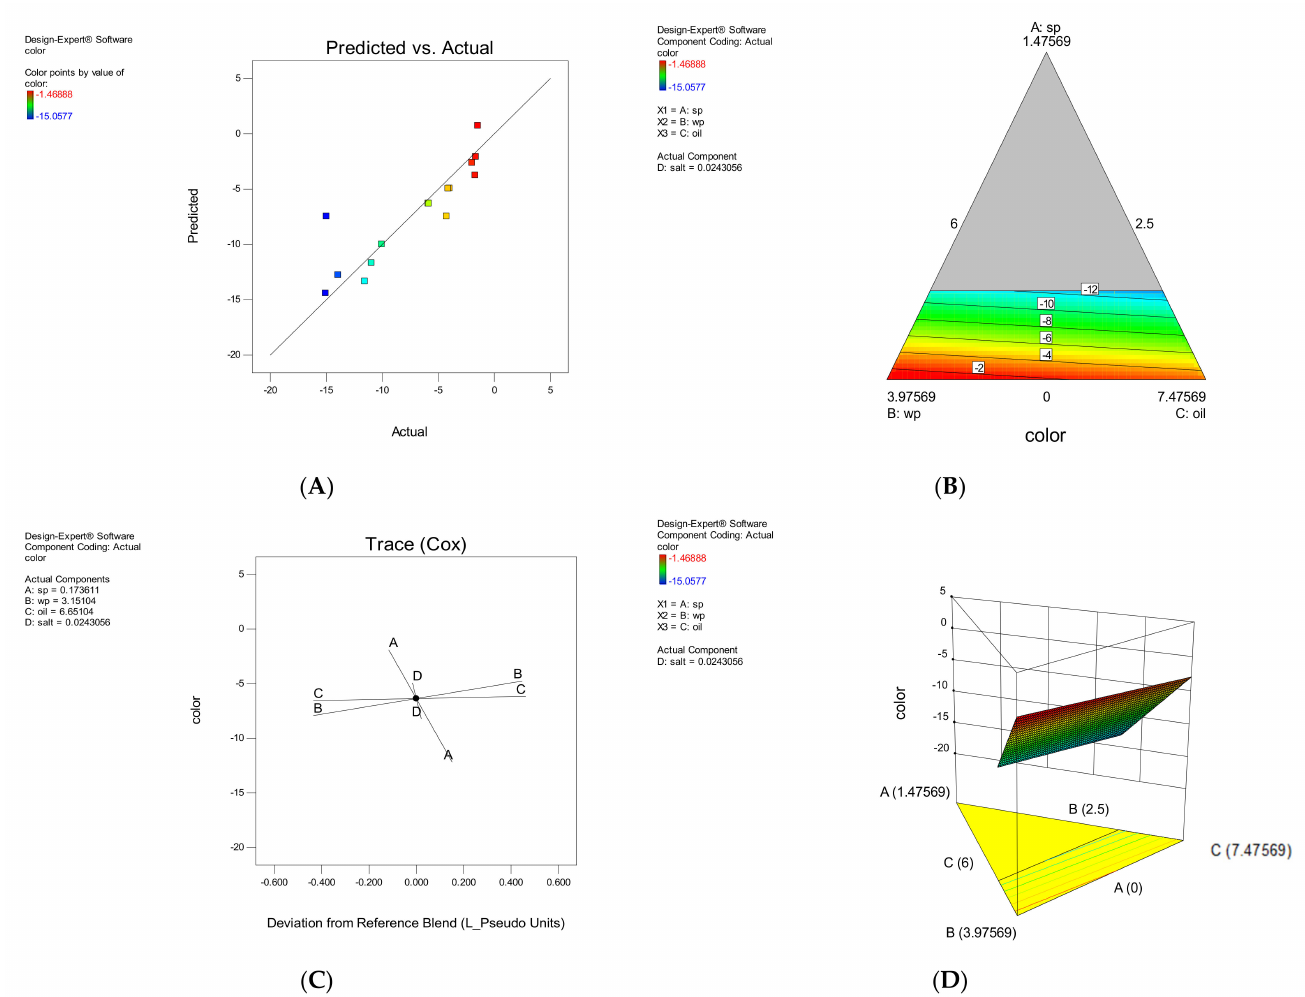
Figure 5. The effect of each parameter on Green color intensity. The correlation between experimental and approximated values ( A ), Contour plot ( B ), Trace plot ( C ), three-dimensional response surface plot ( D